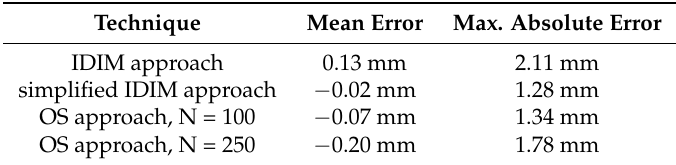
Table 2. Mean and maximum absolute error of the estimated position obtained by different techniques in case the actuator has zero mean